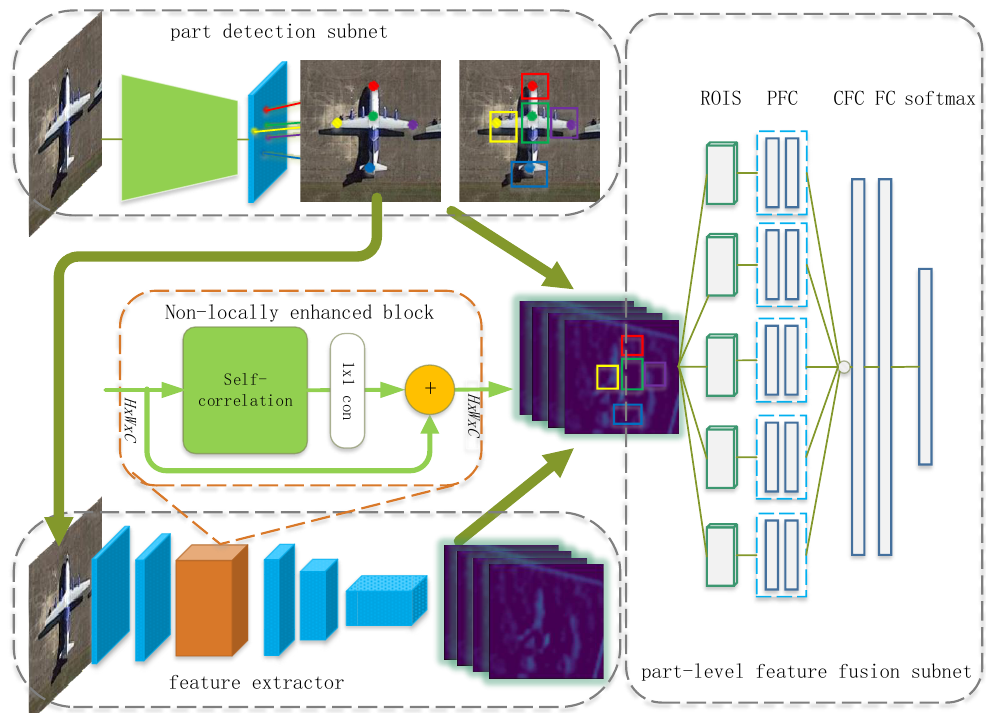
Figure 1. Framework of non-locally enhanced feature fusion network (NLFFnet).